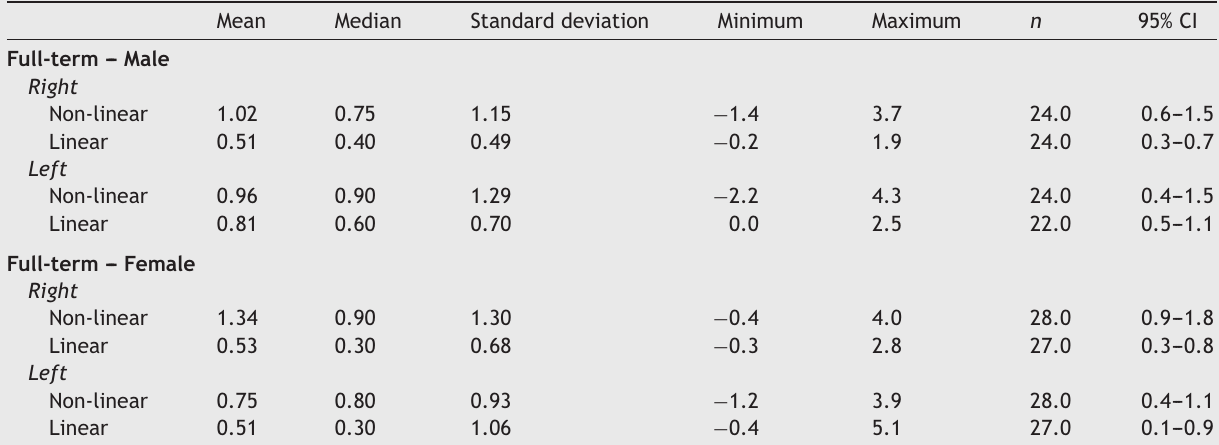
Efferent inhibitory effect of TEOAE with linear and nonlinear clicks (dB SPL) for preterm neonates. Mean Median Standard